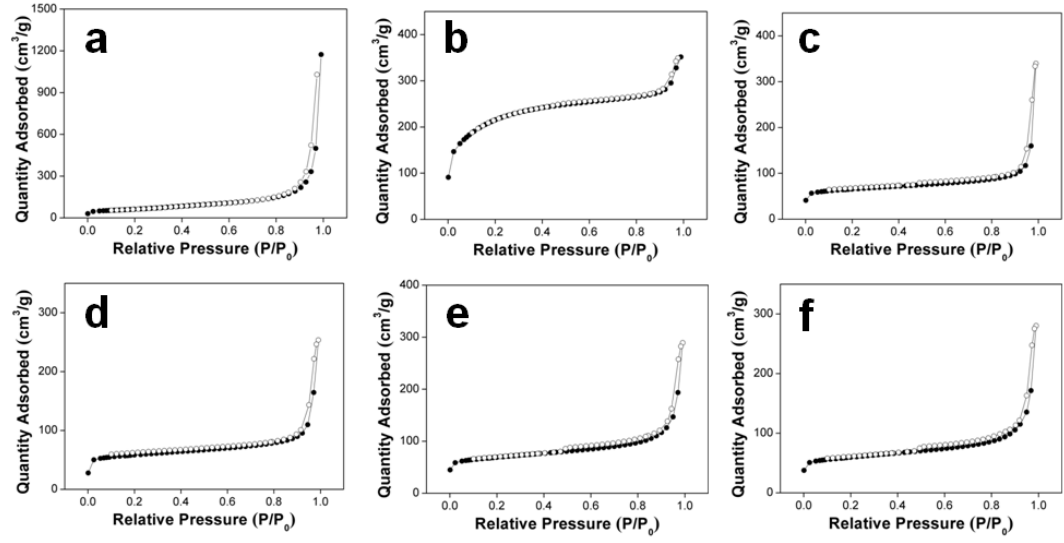
Figure 3. Nitrogen adsorption and desorption isotherms of ( a ) pristine CNTs; ( b ) activated